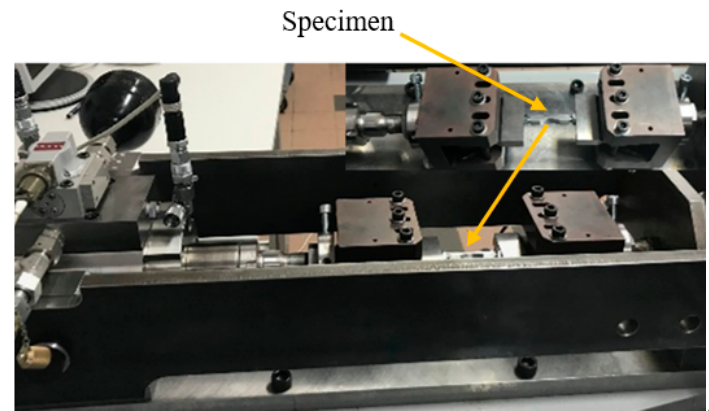
Figure 4. Servo-hydraulic machine for conventional fatigue testing.